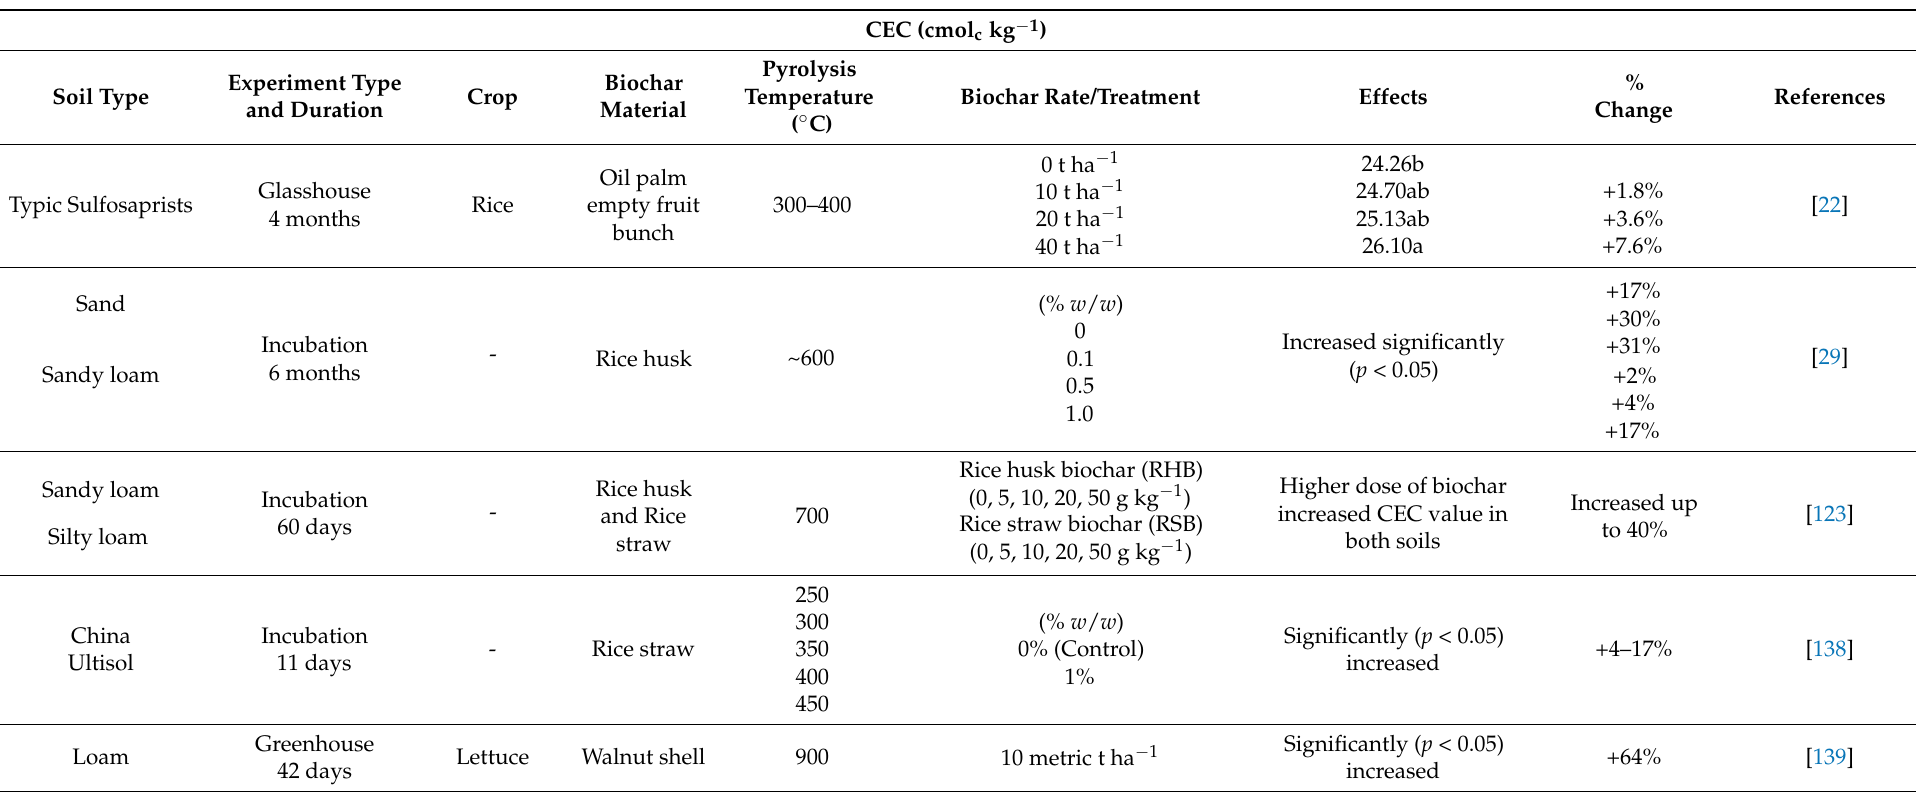
Table 4. Effect of biochar on cation exchange capacity (CEC) of soil (different letters in the same column indicating significant difference among the biochar